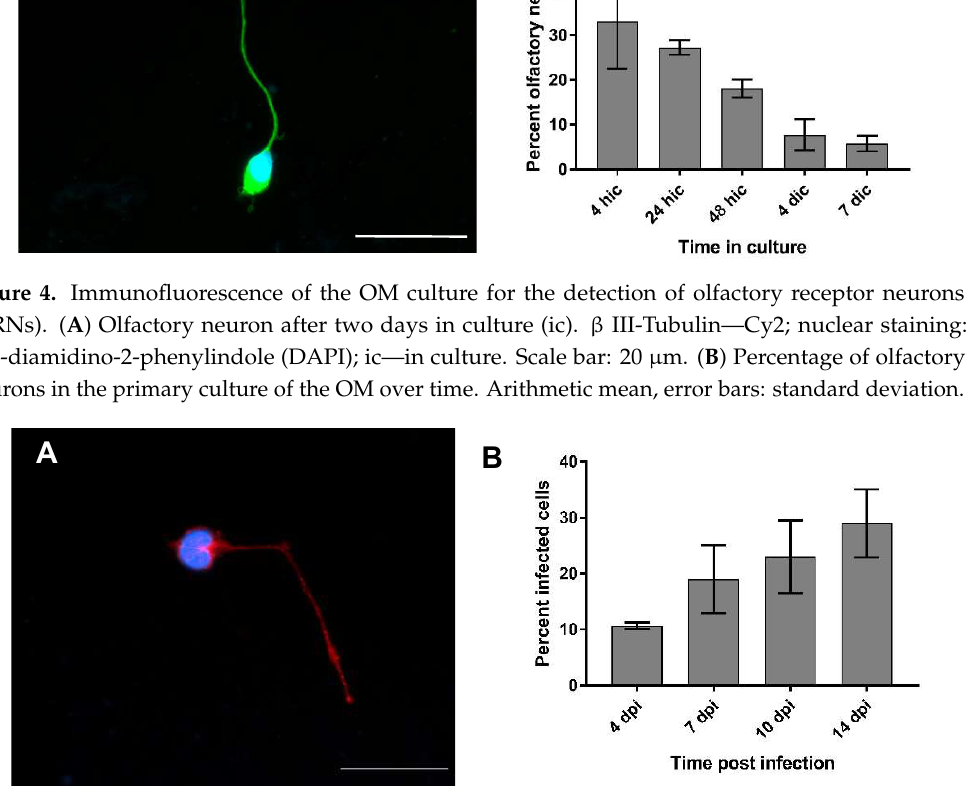
Figure 5. Percentage of BoDV-1-infected cells in the OM culture over time. ( A ) Olfactory neuron at seven dpi. Bo18—Cy3. Nuclear staining: DAPI. Scale bar: 20 µm. ( B ) Percentage of infected cells in the OM culture over time. Arithmetic mean, error bars: standard deviation.